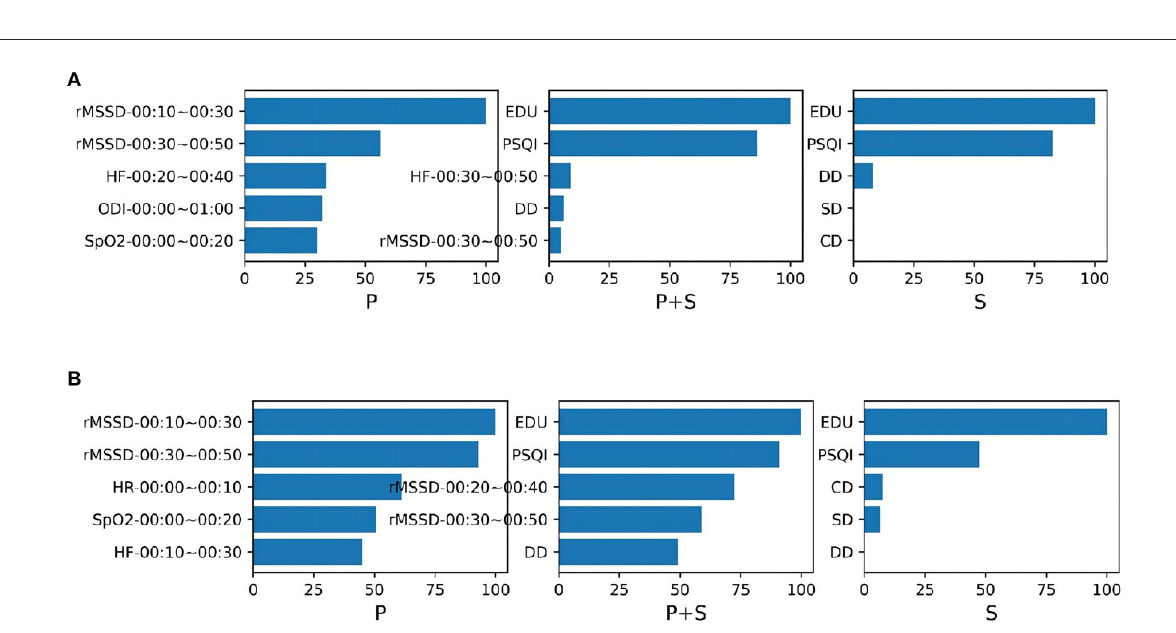
FIGURE6 The top five importance features contribute to the MCI classification models (A) GBDT and (B) XGBoost. Both models were trained from the data containing the physiological function features (P), the data containing the subjective scale features (S), and the data of their combination (P +